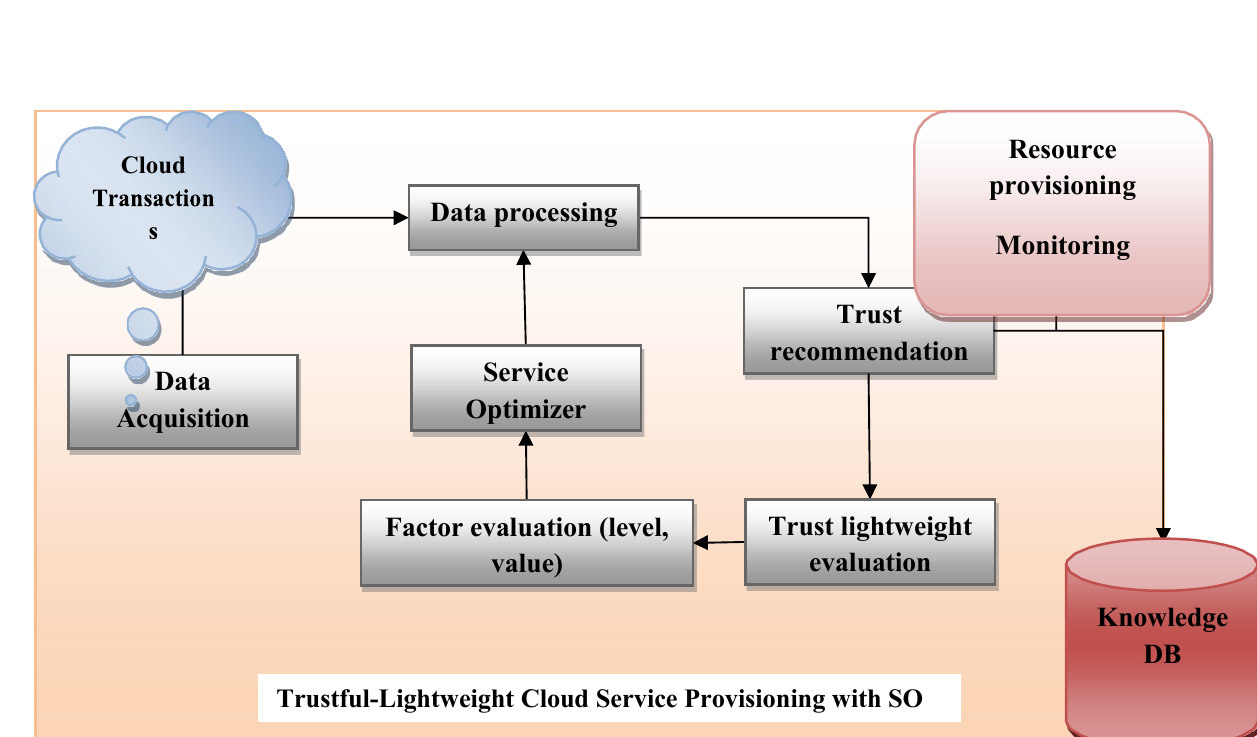
Fig 2. Trustful-lightweight cloud service